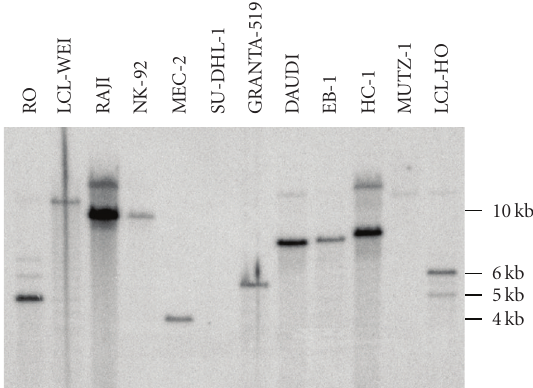
Figure 6: Southern blot analysis of di ff erent cell lines. Fifteen μ g genomic DNA of the cell lines were digested with Xho I and the restriction fragments were separated on an agarose gel. The DNA was blotted onto nylon filters and the blot was hybridized to a ca. 900 bp 32 P-labeled PCR product spanning the 5 (cid:3) -region of EBV (LMP fragment 1). A rehybridization of the same blot with a probe for the 3 (cid:3) -region of the linear EBV genome after stripping revealed the same bands, indicating that circular EBV DNA is